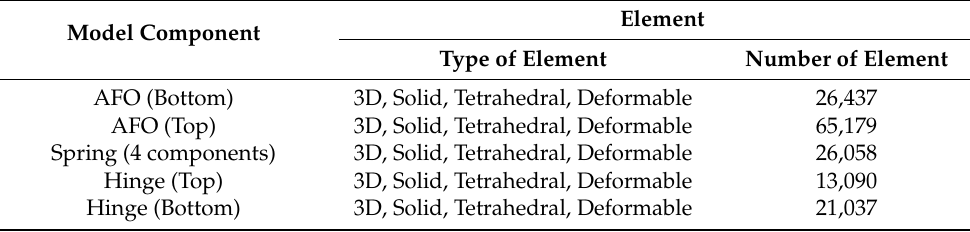
Table 1. The number of elements for the Finite Element Analysis model components.